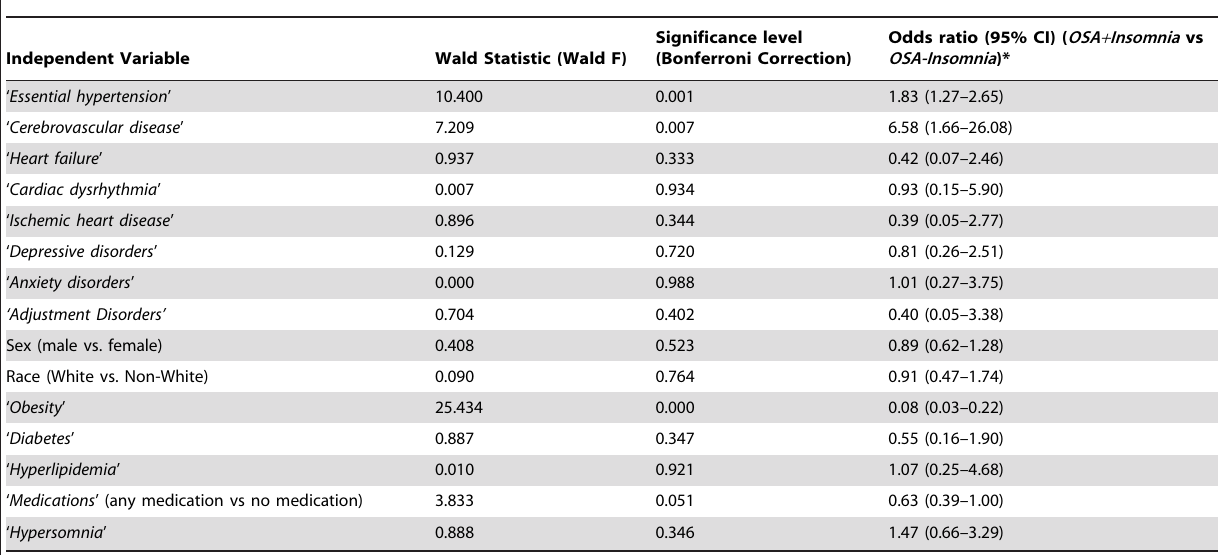
Table 2. Results of logistic regression analysis using Sleep Apnea Plus as the dependent